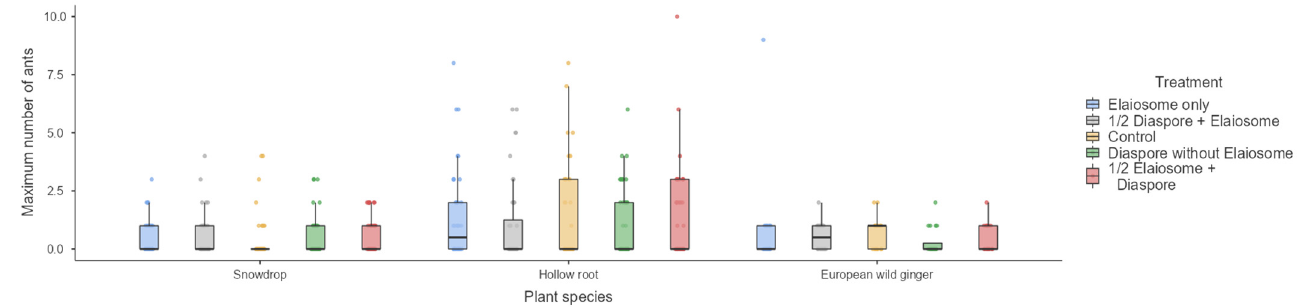
Figure 3. Maximum number of ants observed on diaspores/elaiosomes among three plant species. Box plots represent medians, 25th and 75th percentiles, minimum and maximum values.